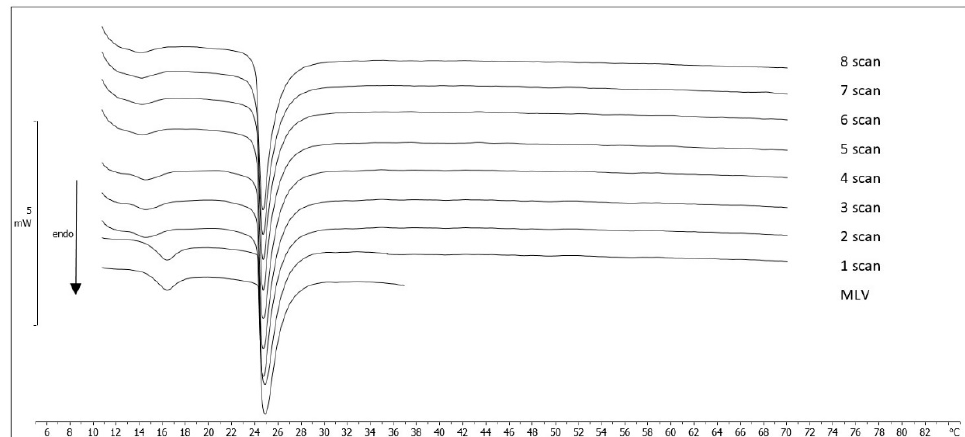
Figure 4. Calorimetric curves, in heating mode, of MLV put in contact with BXL at increasing incubation time. There are 68 min between one scan and the next.